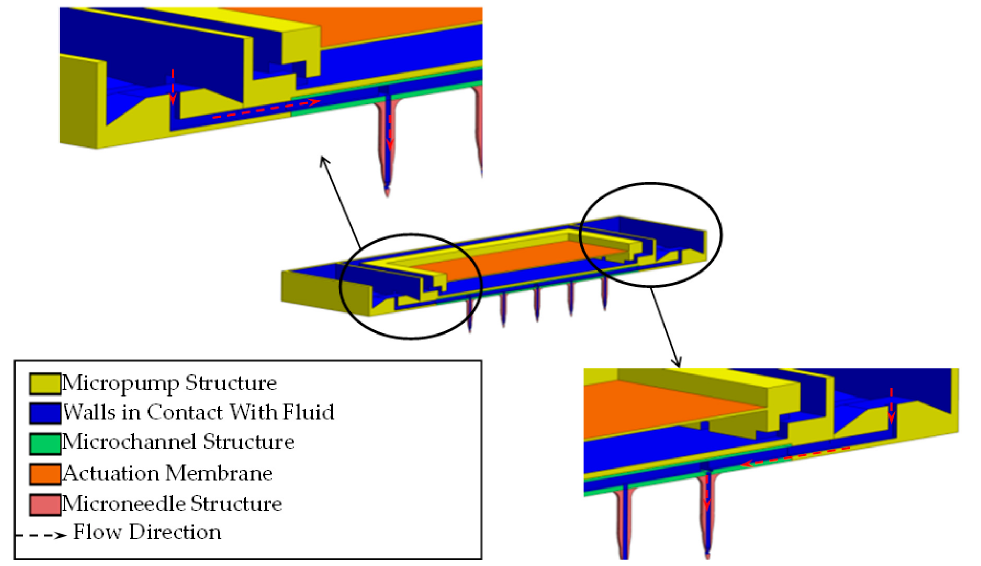
Figure 8. Cross sectional view of the discharge process.